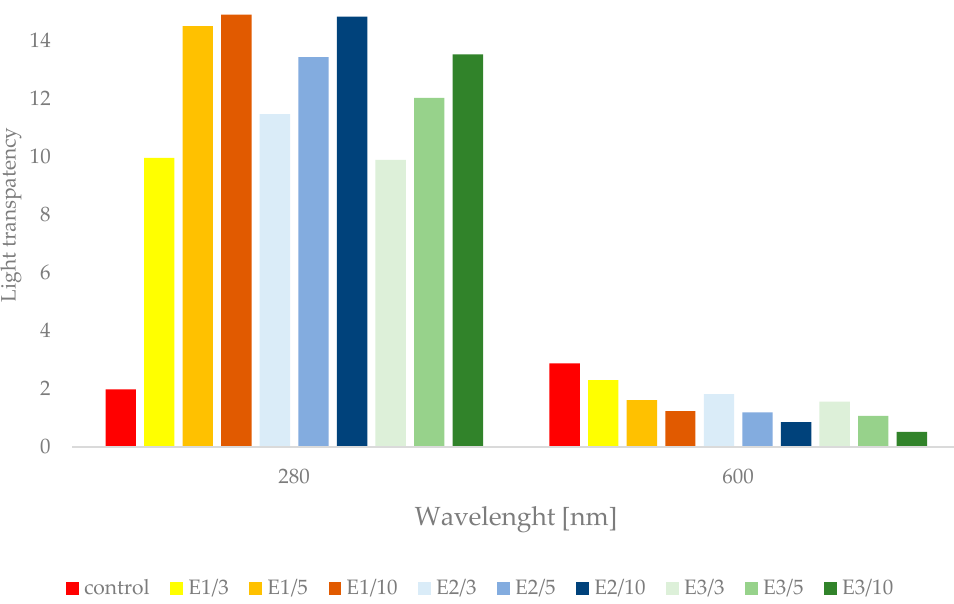
Figure 3. UV and light transparency of pullulan films containing propolis extracts.